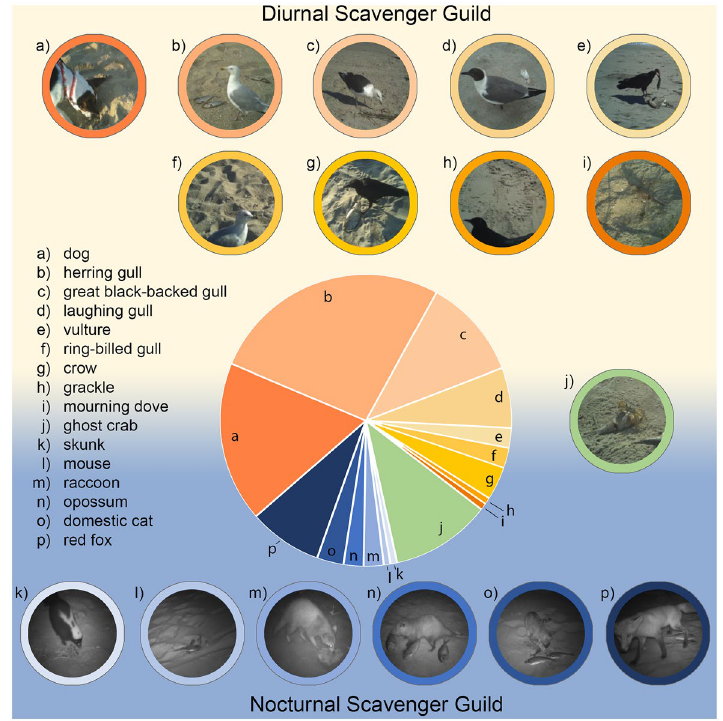
Figure 1. Scavenger species captured with remote infrared motion-triggered cameras on ocean-exposed beaches in New Jersey, USA. Pie chart indicates the proportion of camera locations at which each species was captured. Diurnal scavengers included ( a ) dogs ( Canis familiaris ), ( b ) herring gulls ( Larus argentatus ), ( c ) great black-backed gulls ( L. marinus ), ( d ) laughing gulls ( Leucophaeus atricilla ), ( e ) turkey vultures ( Cathartes aura ), ( f ) ring-billed gulls ( L. delawarensis ), ( g ) crows ( Corvus brachyrhynchos/ossifragus ), ( h ) common grackles ( Quiscalus quiscula ), and ( i ) mourning doves ( Zenaida macroura ). Ghost crabs ( Ocypode quadrata ) ( j ) were observed during both deployment periods. Nocturnal scavengers included ( k ) skunks ( Mephitis mephitis ), ( l ) white-footed mice ( Peromyscus leucopus ), ( m ) raccoons ( Procyon lotor ), ( n ) opossums ( Didelphis virginiana ), ( o ) domestic cats ( Felis sylvestris ), and ( p ) red foxes ( Vulpes vulpes